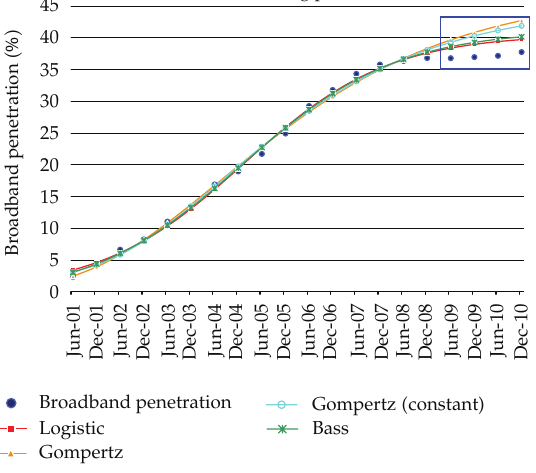
Figure 27: The forecasting performance of the optimized di ff usion models for Denmark (cid:2) forecast period—2 years ahead (cid:3) .